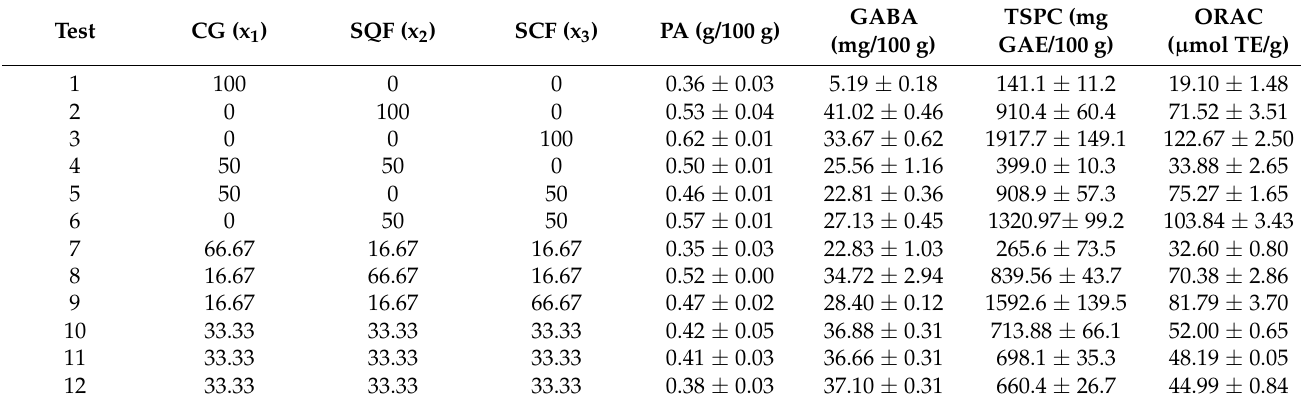
Table 3. PA, GABA, TSPC and ORAC in extrudates elaborated with different ratios of CG, SQF and